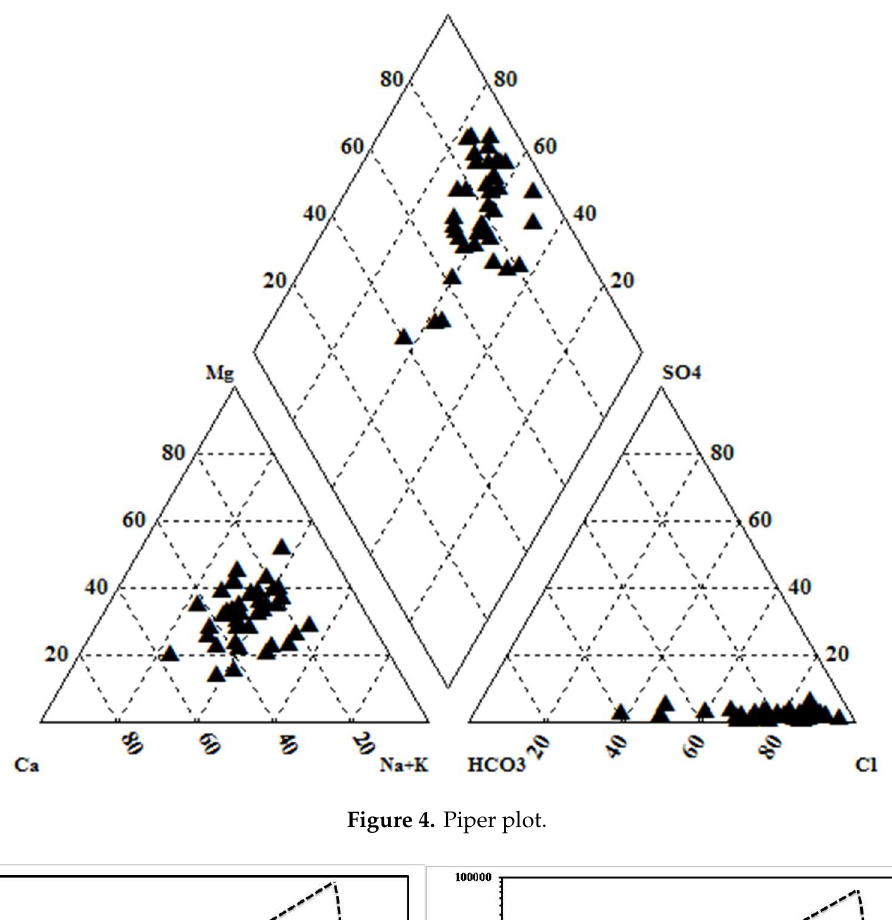
Figure 3. Spatial distribution of EC in the study area.